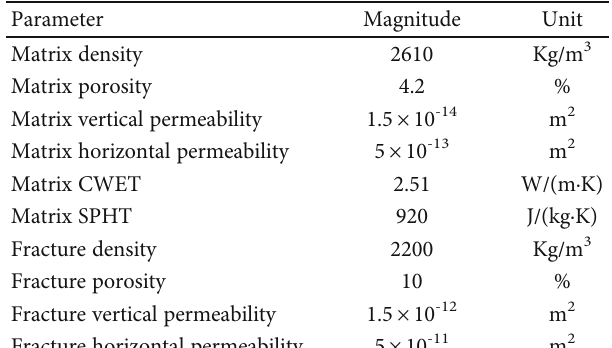
in the k , k , and P columns refers to l rl rg cap